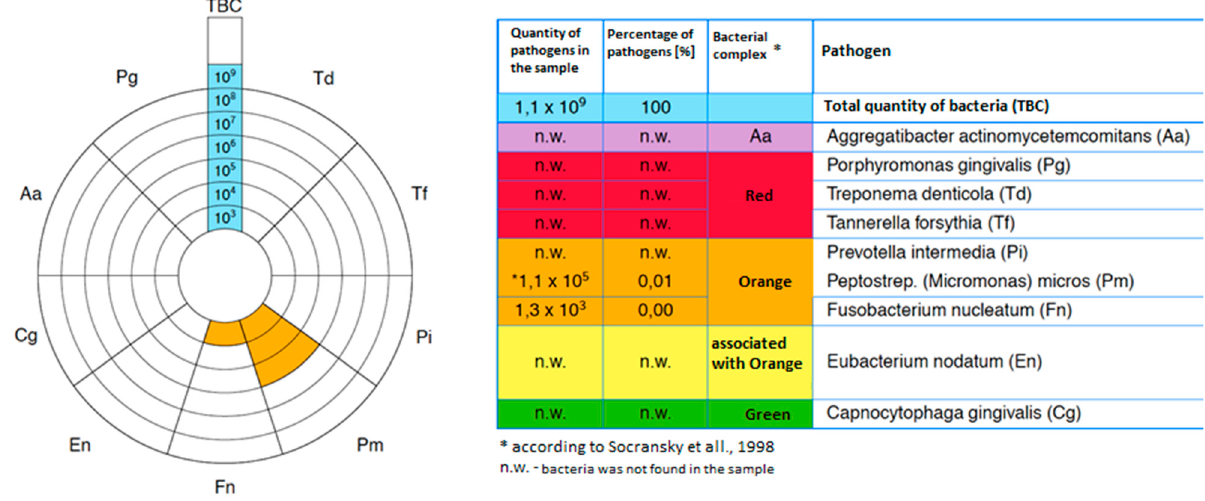
Figure 6. Bacterial profile of the biofilm present in the peri-implant pocket in th clinical case referred to in Figure 2, before ( A ) and after ( B ) treatment with a bioactive healing abutment (BHA) containing clindamycin. Real-time PCR study. 4. Discussion This is the first study to present a novel method of mucositis treatment in patients after implantoprosthetic proceedings. To date, there has been no constructed study on animals concerning the use of the bioactive healing abutment containing an antibiotic. The differences in bacterial contamination between animals and humans seems to constitute an insurmountable obstacle at present. An animal’s tooth size is significantly different to